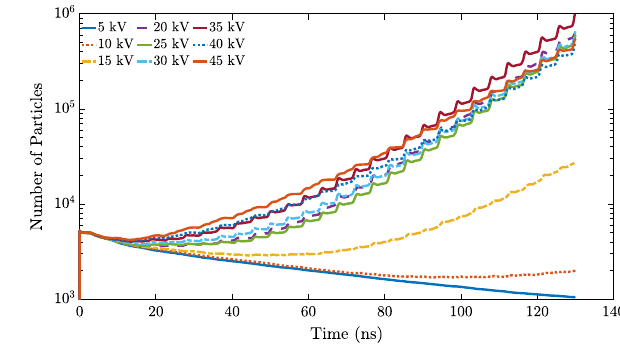
FIG. 5. Number of particles within the cavity as a function of